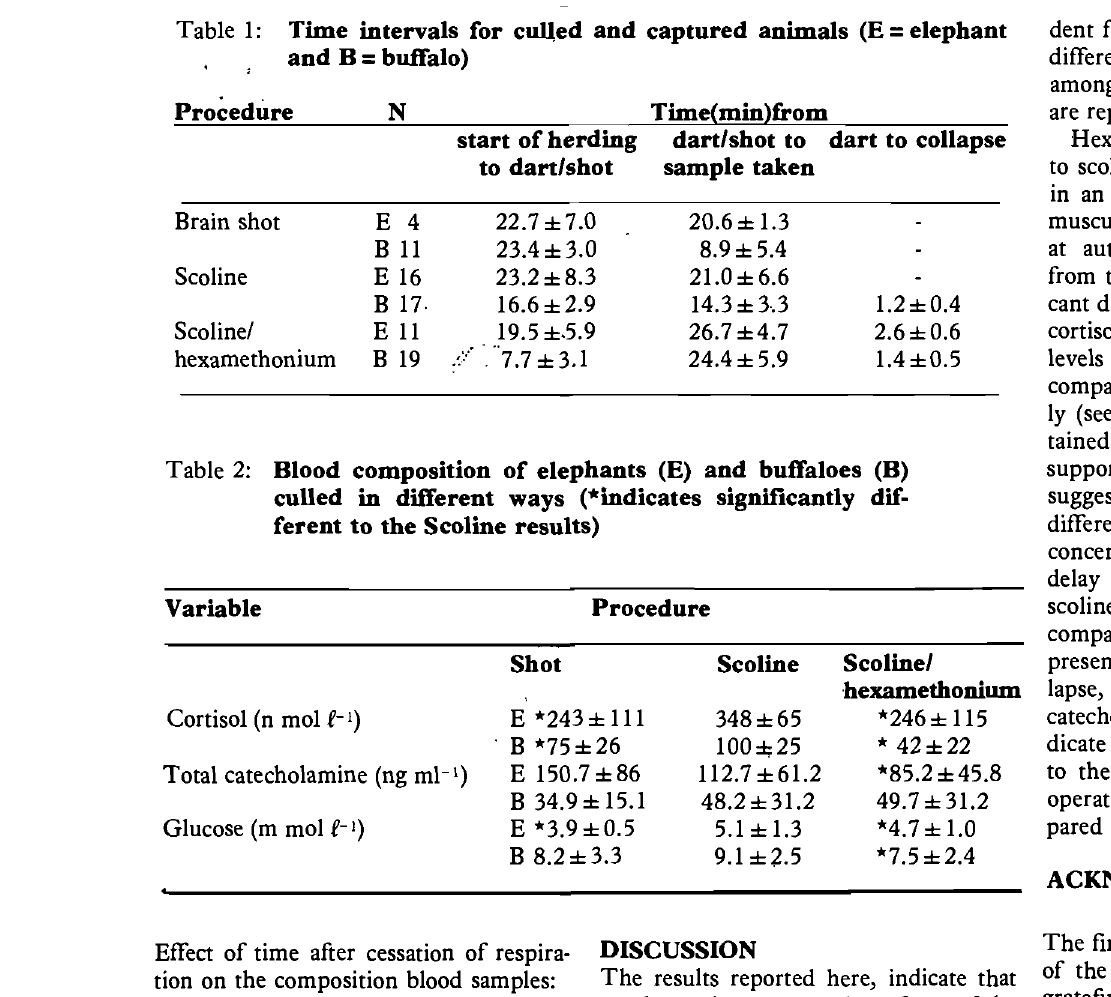
Table 1: Time intervals for culled and captured animals (E = and B buffalo) Procedure N Time(min}from start of herding dart/shot to dart to collapse to dart/shot sample taken Brain shot